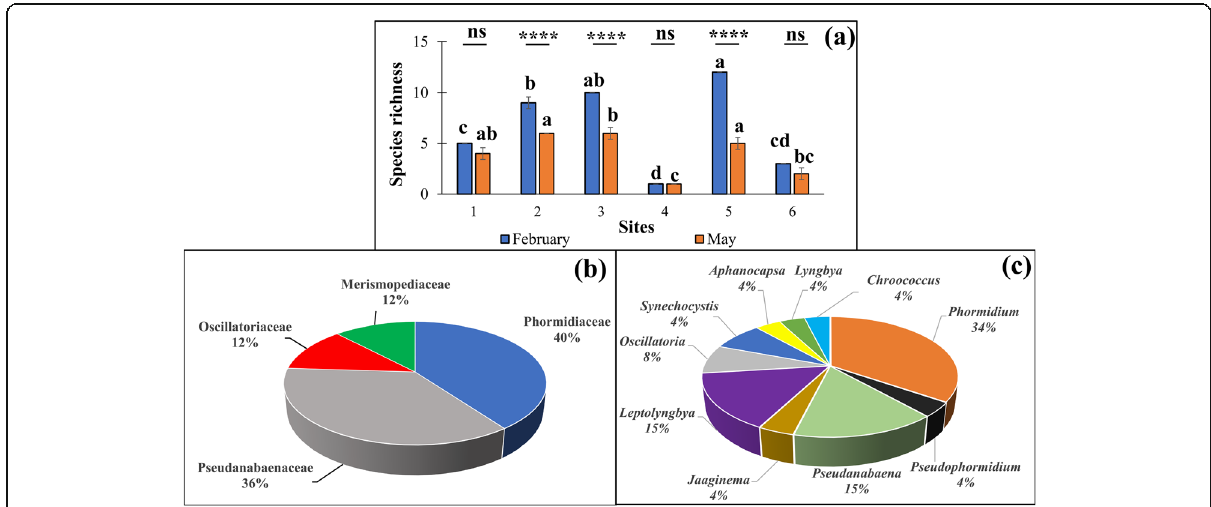
Fig. 3 Species richness ( a ), spectrum families ( b ), and spectrum genera ( c ) of cyanobacteria in the studied soils. Data are means ± standard error ( n = 3). Different letters (3a) indicate significant differences ( p < 0.05 by Tukey ’ s HSD test) between sampled sites, NS: not significant; * p < 0.05 significant difference;